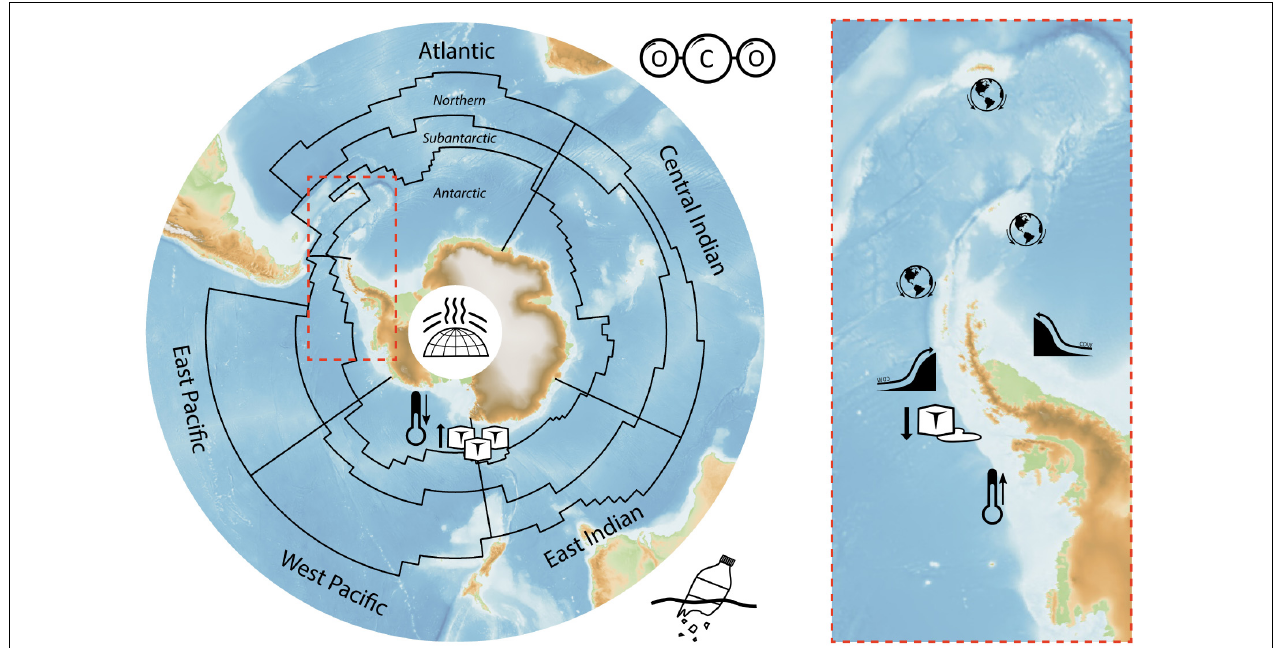
FIGURE 2 | Areas for assessing effects of global drivers in the Marine Ecosystem Assessment of the Southern Ocean (black lines) with the Antarctic Peninsula highlighted (red dashed box). The five sectors (Atlantic, Central Indian, East Indian, West Pacific and East Pacific) and zones (Antarctic, Subantarctic and Northern) are labeled. Zonal boundaries are the Southern ACC Front between Antarctic and Subantarctic zones, and the Subantarctic Front between Subantarctic and Northern zones, with the Subtropical Front to the north. Icons indicate currently identified critical locations for increase and decrease in temperature and sea ice, potential for invasive species, and where circumpolar deep water is increasingly shoaling onto the continental shelf. They also illustrate general effects of ozone depletion, pollution and ocean